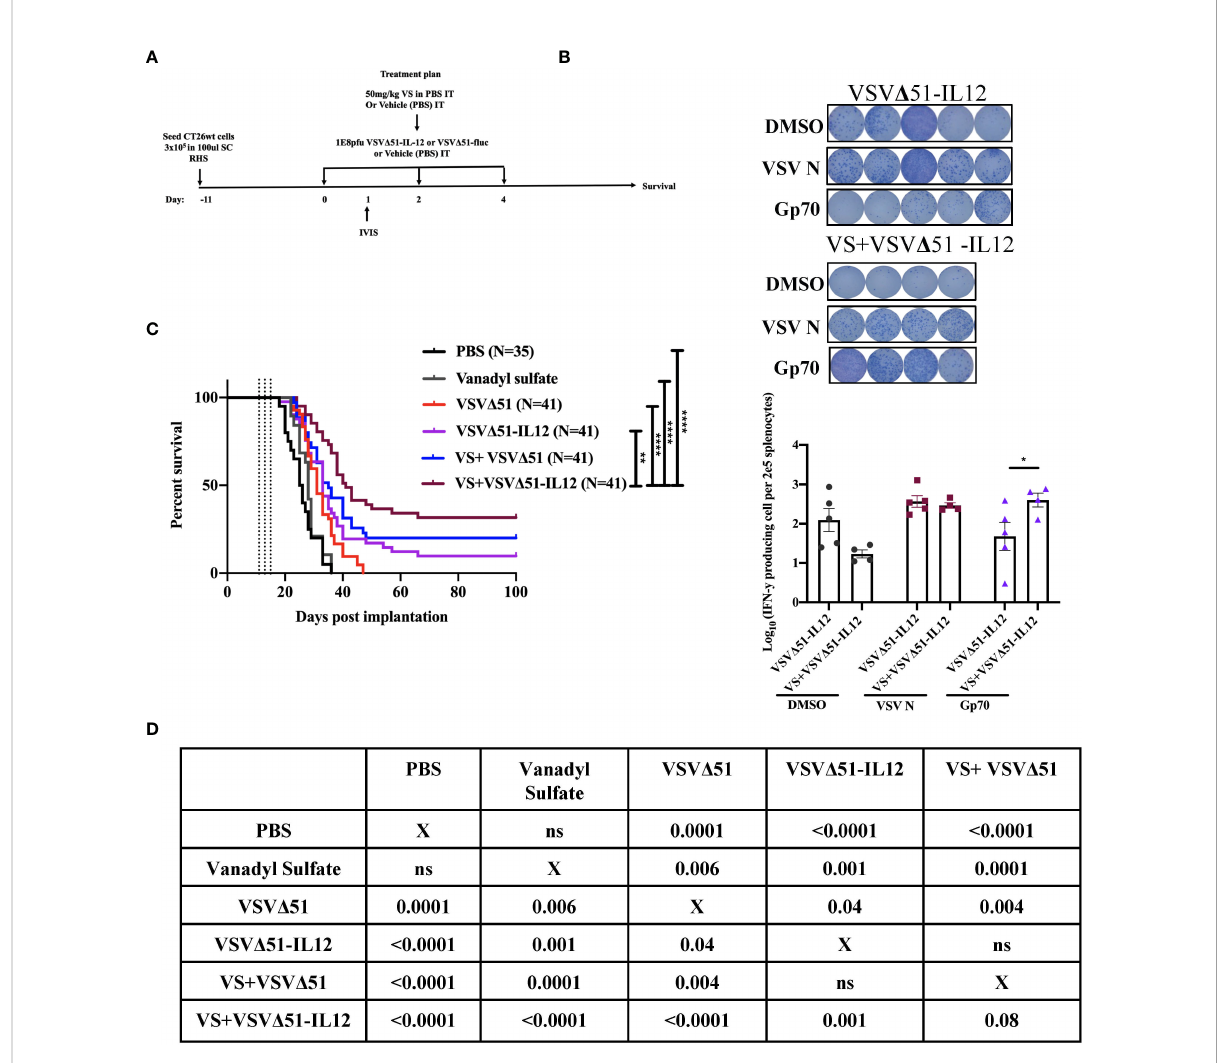
FIGURE 5 Vanadyl sulfate in combination with VSV D 51 encoding/expressing IL-12 improves the therapeutic ef fi cacy in CT26WT-tumor model (A) Schematic representation of the treatment schedule: CT26WT-tumor-bearing mice received a total of three dose delivered intratumorally of vanadyl sulfate (50mg/kg) and VSV D 51 expressing IL-12 (1E8 PFU) or with PBS, vanadyl sulfate (50mg/kg), or VSV D 51 expressing IL-12 (1E8 PFU) alone over 5 days. (B) Survival was monitored over time, the percentage of survival was included for each condition, Long rank (Mantel-Cox) test indicated the signi fi cance as shown in table below. Survival data represents an aggregate of 3 independent studies. (C) as part of Figure 2, two additional groups received three intratumorally vanadyl sulfate (50mg/kg) and VSV D 51 expressing IL-12 or monotreatment injections over 5 days. representative data from ELISPOT assay and Graph shows quanti fi cation of log 10 of the number of IFN- g producing cells per 2E5 splenocytes. Mean ± SEM; * P=0.01, ** P=0.003, ****P<0.0001, Two-way ANOVA. (D) Table shows the signi fi cance values using Long rank (Mantel-Cox), * P=0.01, ** P=0.003,